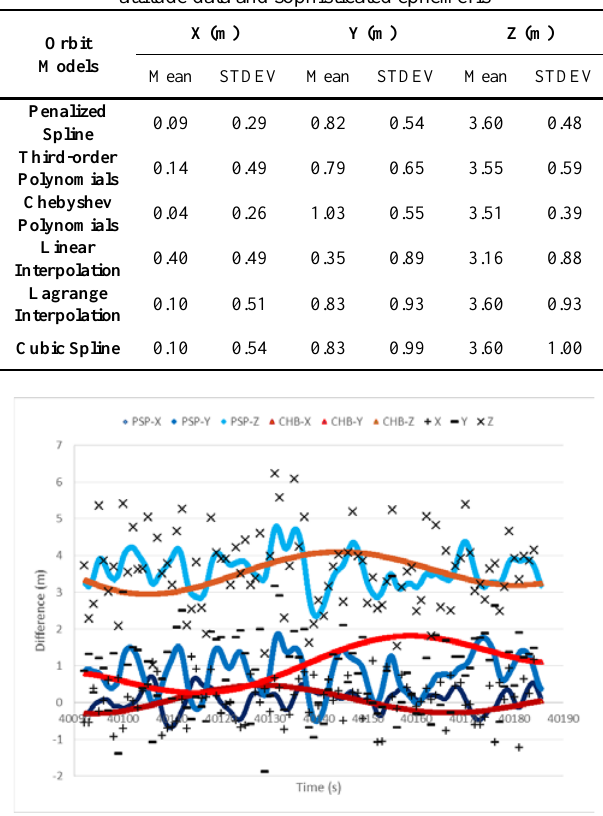
Figure 1. Differences between the attitude data and sophisticated